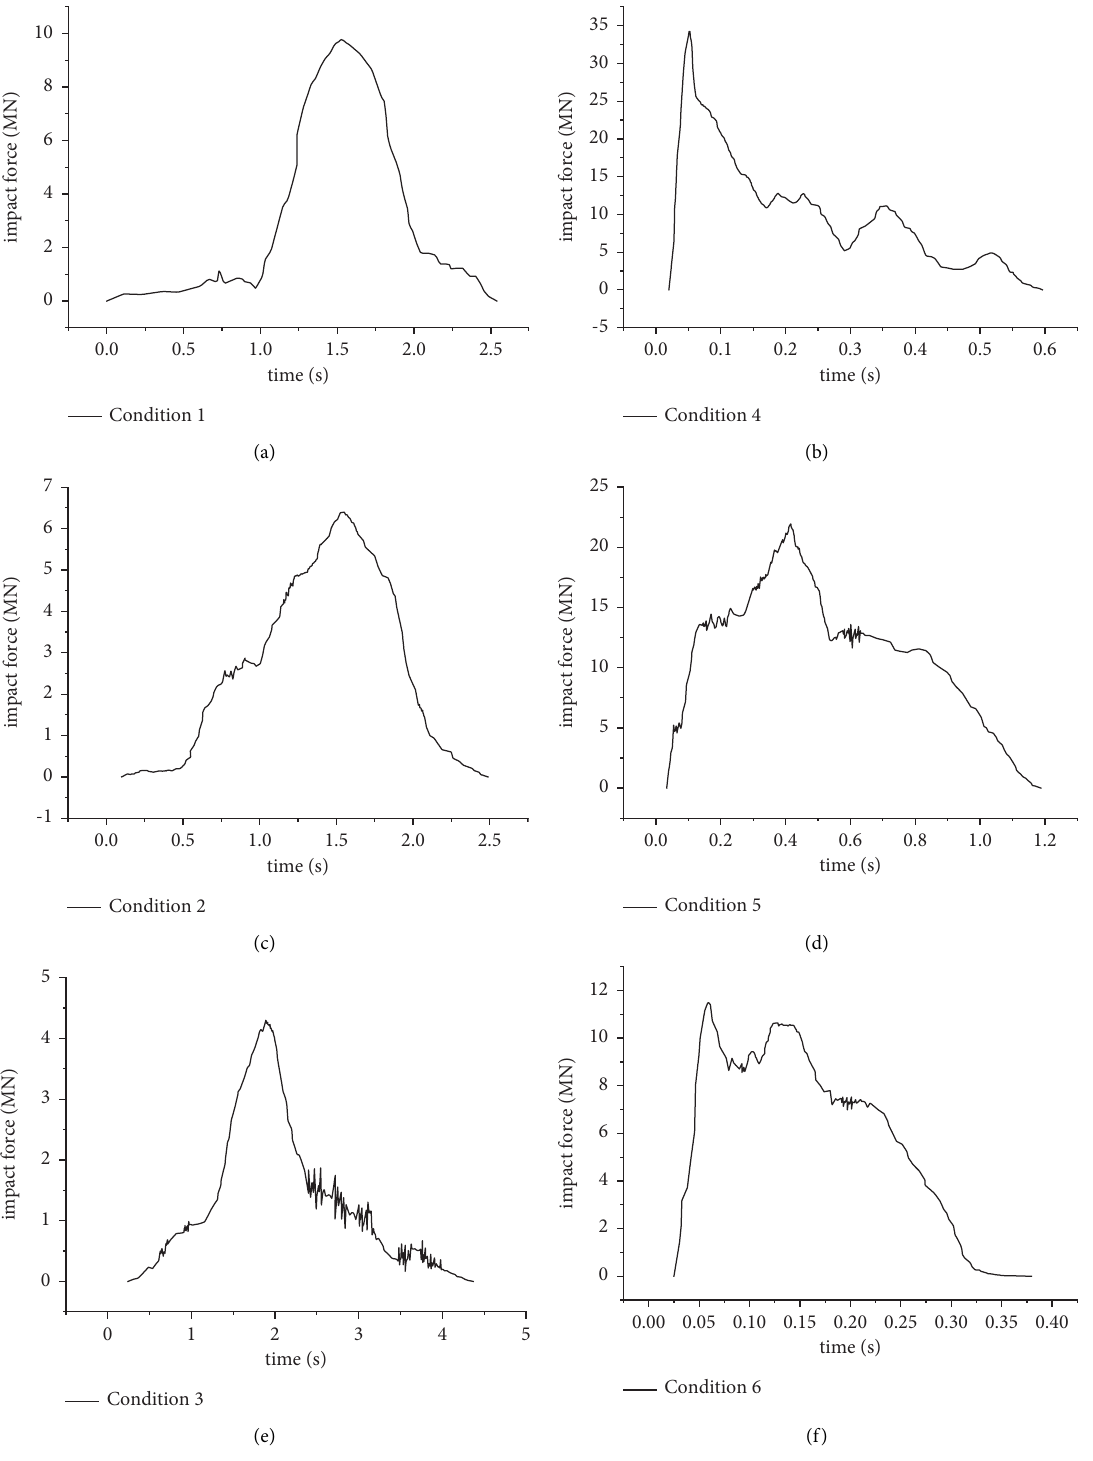
Figure 8: Time of impact force under different conditions. (a) 90 ° impact with protective devices under working condition 1. (b) 90 ° impact with protective devices under working condition 4. (c) 60 ° impact with protective devices under working condition 2. (d) 90 ° impact with protective devices under working condition 5. (e) 30 ° impact with protective devices under working condition 3. (f) 30 ° impact with protective devices under working condition